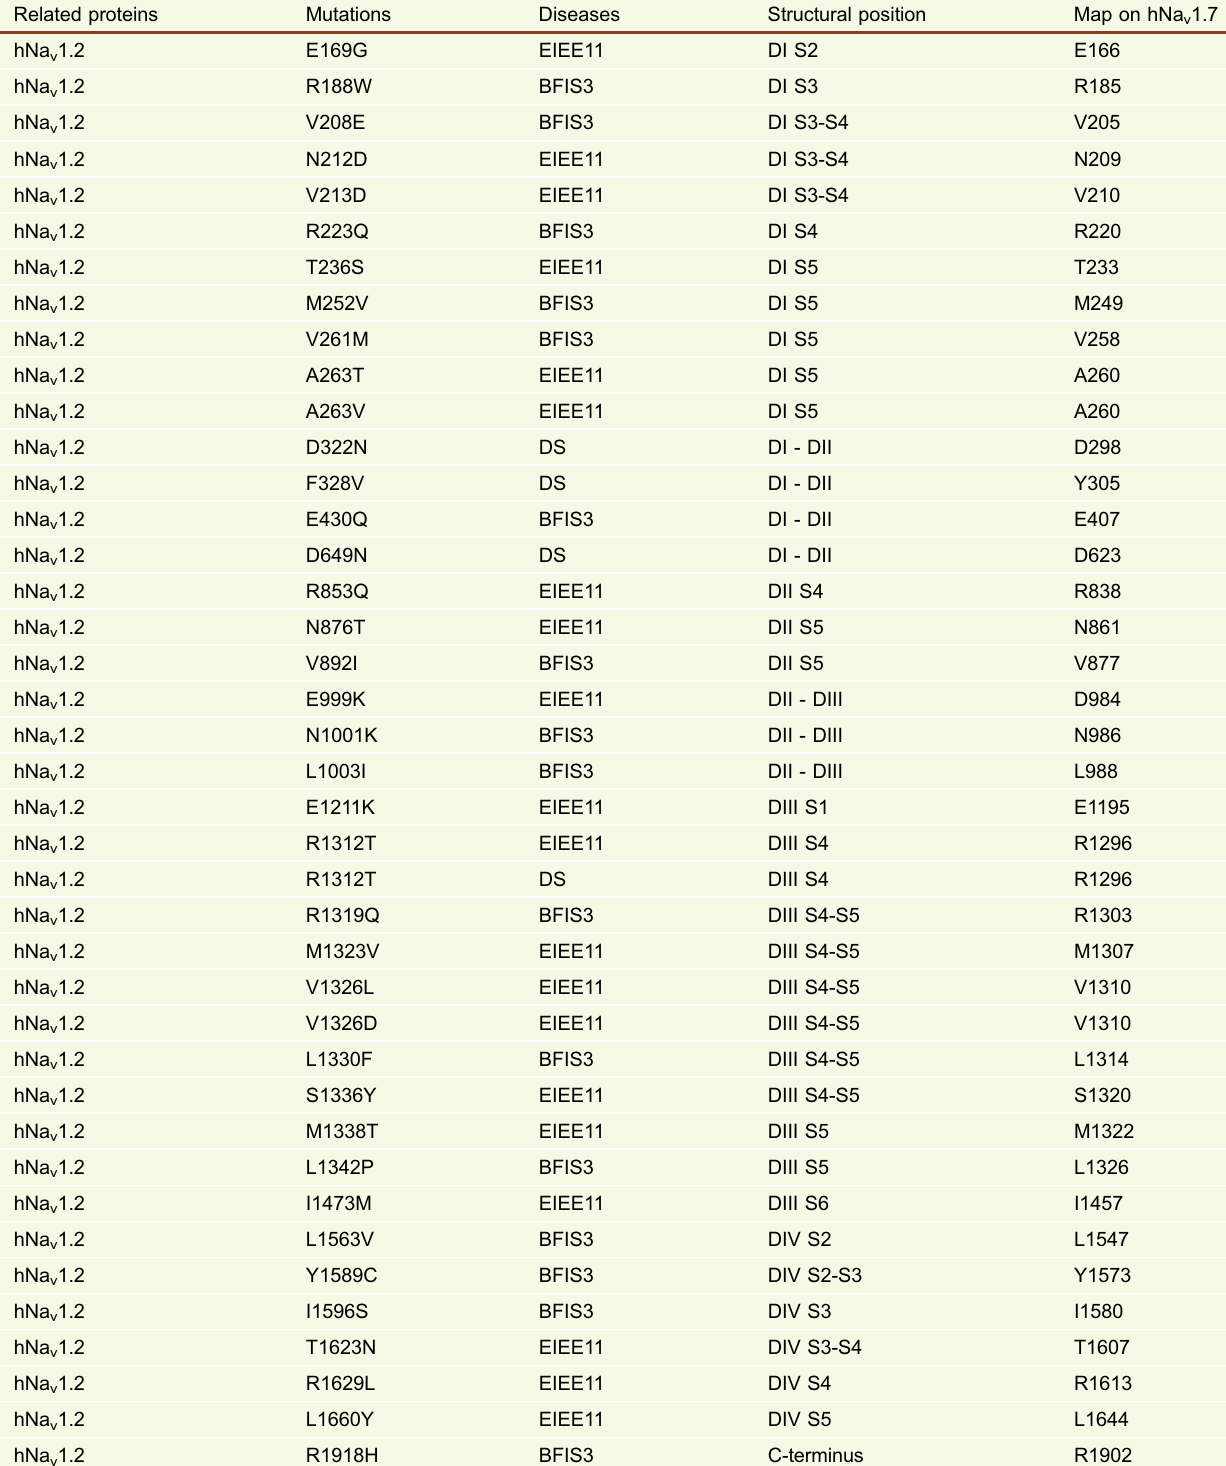
Table 3. Structural mapping of disease-related mutations identi fi ed in human Na v 1.2